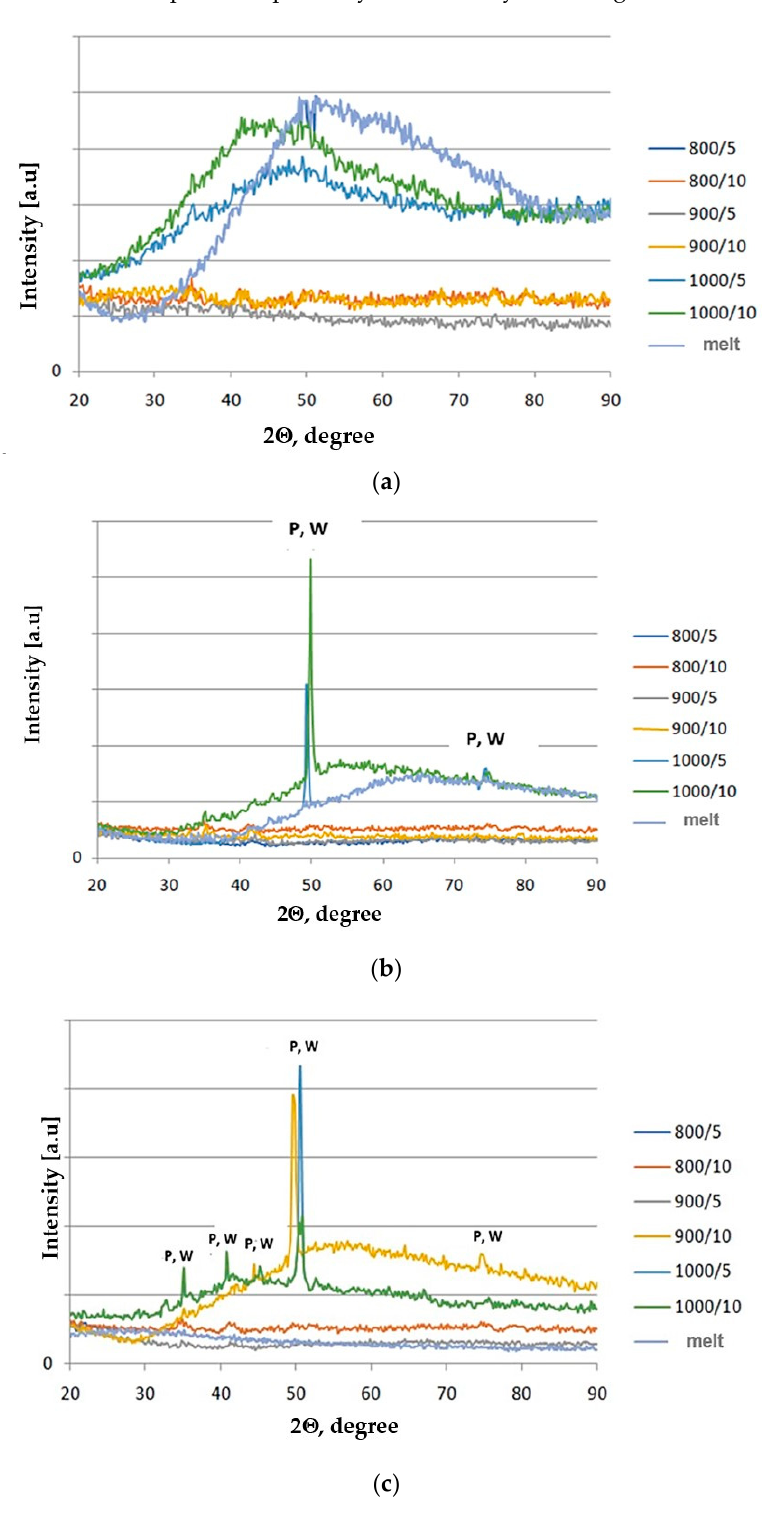
Figure 8. X-ray diffractograms of amphibolite glasses after after crystallization process: ( a ) 100 wt.% amphibolite (Set 1*), ( b ) 90 wt.% amphibolite + 10 wt.% dolomite (Set 2*), ( c ) 80 wt.% amphibolite + 20 wt.% dolomite (Set 3*); P—Pyroxene, W—Wollastonite.